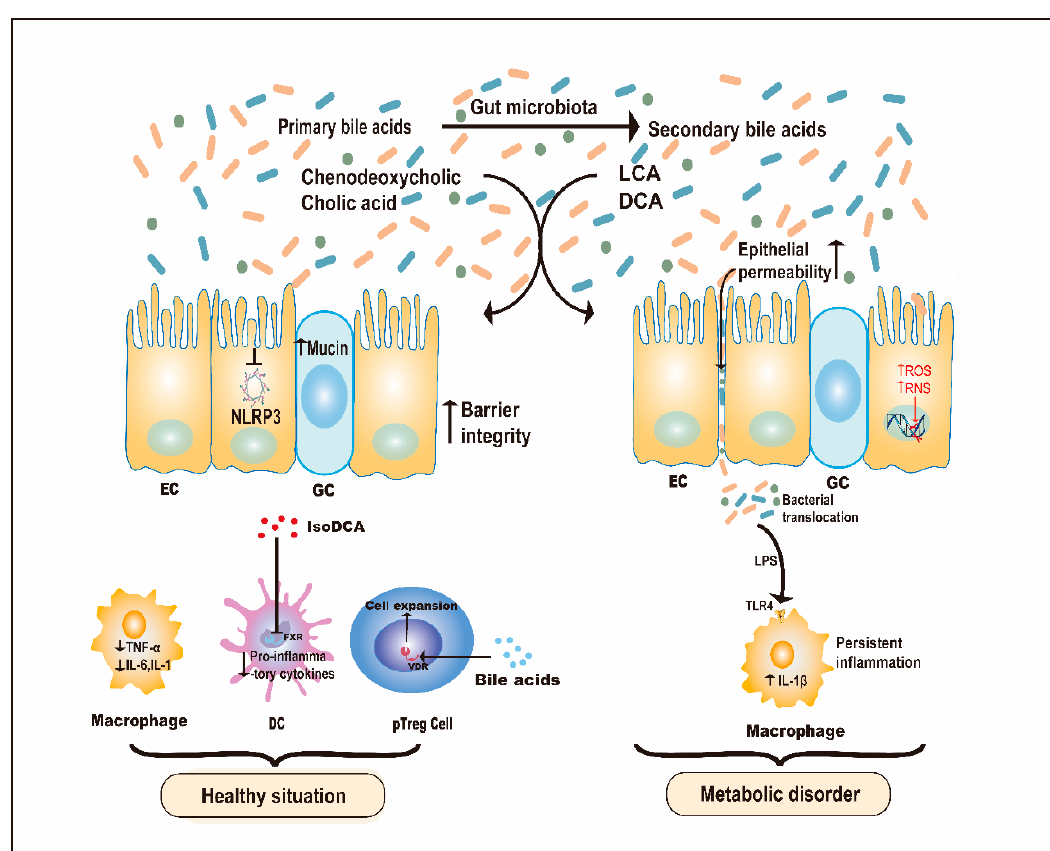
Figure 3. Immunoregulatory effects of bile acids on host cells. Bile acids consist of primary bile acids (such as cholic acid and chenodeoxycholic acid) and secondary bile acids, including deoxycholic acid (DCA) and lithocholic acid (LCA). The latter is metabolized from the former by gut microbiota. In the healthy situation, both types of bile acids can inhibit the activation of the NLRP3 inflammasome in epithelial cells (ECs), downregulate proinflammatory cytokines, such as IL-6 and IL-1, in macrophages and dendritic cells (DCs), and promote peripheral-induced regulatory T (pTreg) cell expansion in a vitamin D receptor (VDR)-dependent manner. IsoDCA, a secondary bile acid, contributes to pTreg cell expansion by counteracting farnesoid X receptor (FXR) in DCs. Additionally, they promote the secretion of mucin in goblet cells (GCs), which helps to enhance the gut barrier. However, when there is a metabolic disorder caused by a high-fat diet, the concentration of bile acids, especially secondary bile acids, are elevated, resulting in a high level of reactive oxygen species (ROS) and reactive nitrogen species (RNS), and increased epithelial permeability, which causes translocation of bacteria and their metabolites and persistent inflammation.